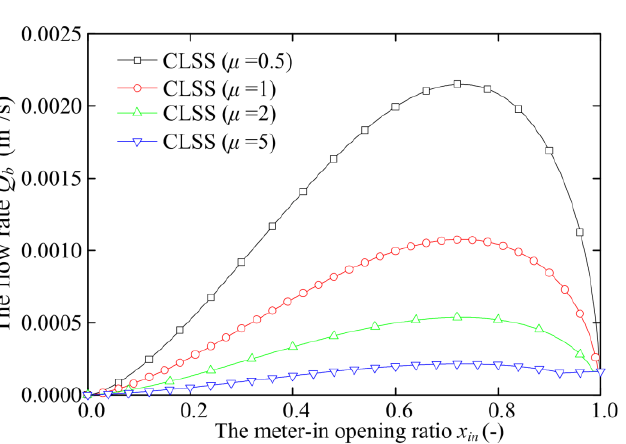
Figure 15. The flow rate Q a of the cylinder head chamber of CLSS with extension working mode.